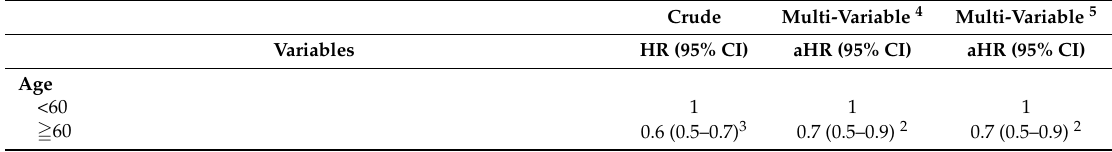
Figure 2. Survival curve of the cumulative time (weeks) to return to work for study participants after occupational injury, stratified by BSRS-5 scores within 1 year post injury. (Note: BSRS-5: 5-item Brief Symptom Rating Scale; Short dashed line: BSRS-5 ≥ 6; Long dashed line: BSRS-5 < 6.) Table 2. Crude and adjusted hazard ratio of potential return-to-work-related factors 6 years after occupational injury.